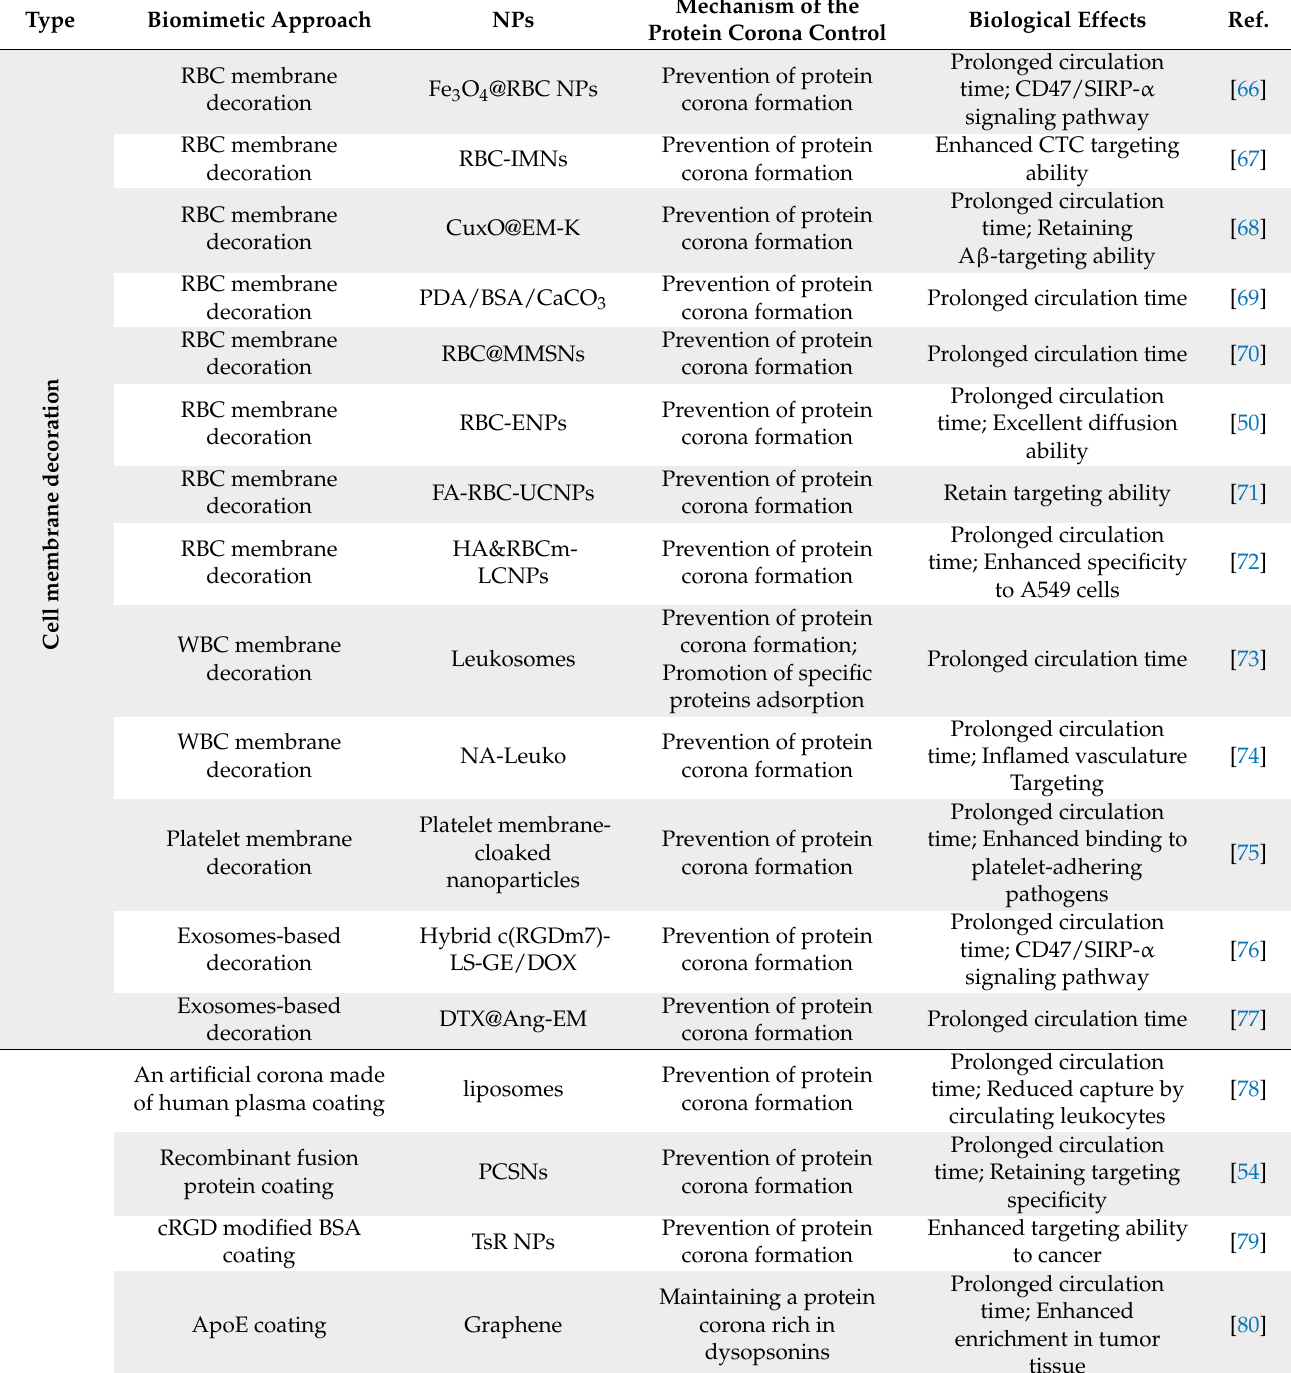
Table 1. Summary of recent studies of biomimetic approaches in nanomedicine to harness pro- tein